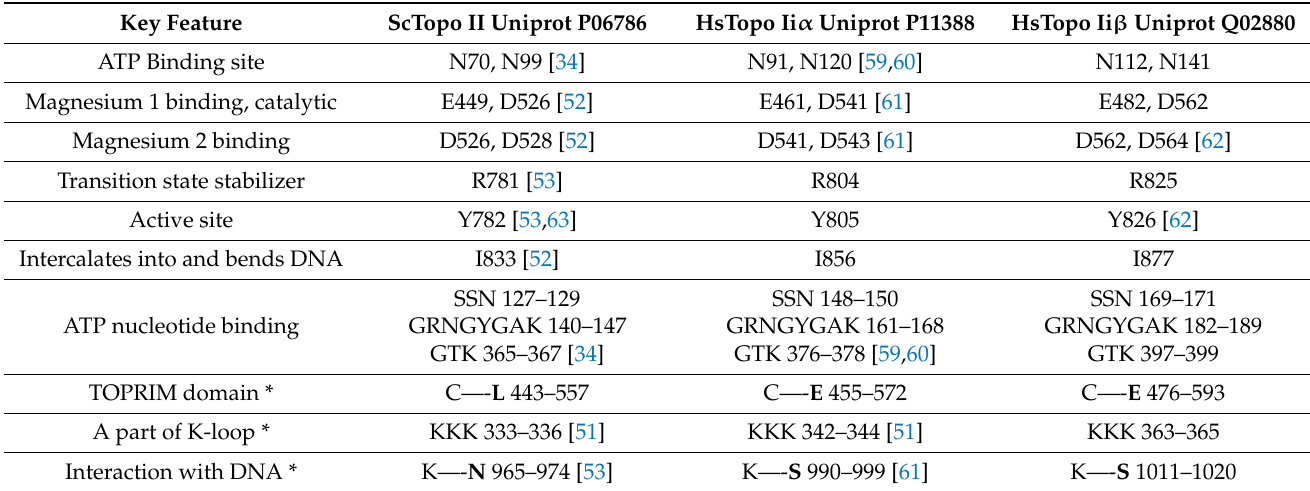
Table 1. Key amino acid sites and their importance in ScTopo II and human counterparts (HsTopo II α ; HsTopo Ii β ). * Sites of